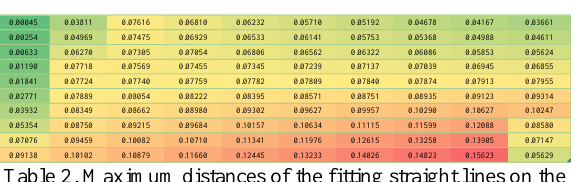
Table 1 indicates that the curvatures of epipolar curves, corresponding to 100 evenly distributed points on the right image are somehow similar. The maximum value is 75.49091 degrees, and the minimum value is 75.48183 degrees, with a variation range being about 0.00908 degrees. The average slope value of straight lines fitted from curves is 75.487 degrees. If the average image, the maximal error exits at the edge of the image, which is about 0.415 pixels.